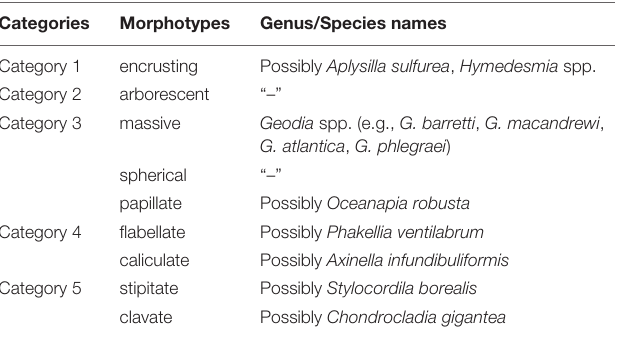
TABLE 2 | Categories of sponge morphotypes in the Faroe Shetland Channel Nature Conservation Marine Protected Area (FSC NCMPA).